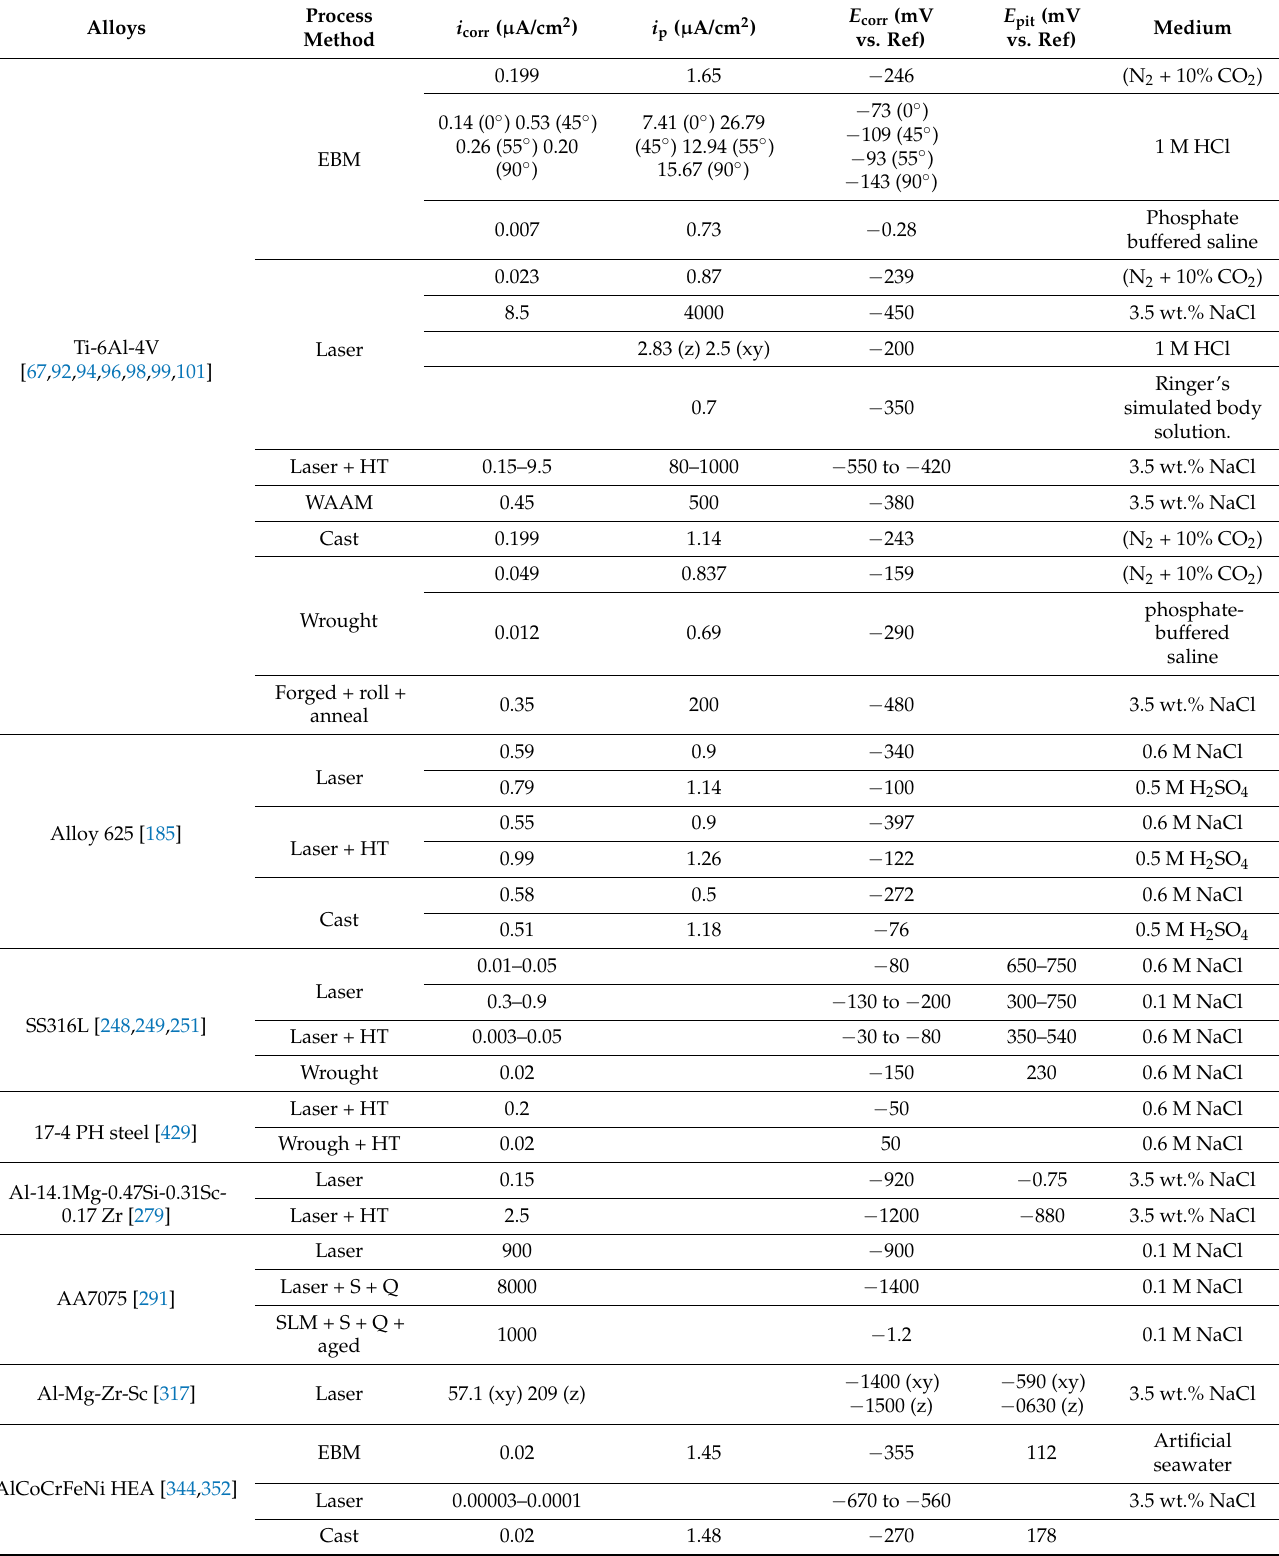
Table 2. Summary of corrosion properties of additively manufactured alloys ( i corr : corrosion current density; i p : passive current density; E corr : corrosion potential; E pit : pitting